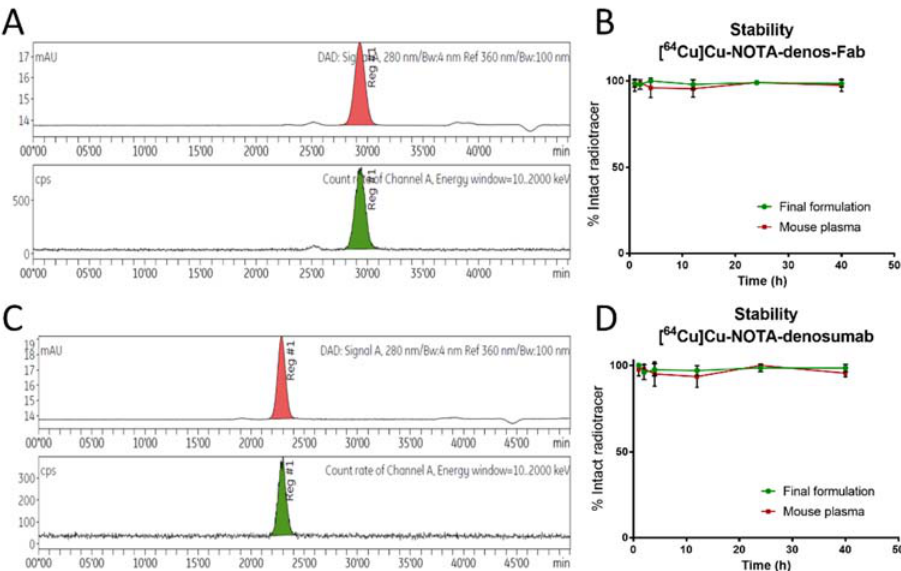
Cell binding of both radiotracers to a positive cell line (RANKL ‐ ME ‐ 180) and negative cell line (native ME ‐ 180) was evaluated in vitro to visualize target binding and specificity. The percentage associated cell ‐ bound activity for [ 64 Cu]Cu ‐ NOTA ‐ denos ‐ Fab was signifi ‐ cantly higher on the RANKL ‐ transduced cells (6.7 ± 0.8%) compared with the blocking con ‐ Figure 2. [ 64 Cu]Cu-NOTA-denos-Fab/denosumab characterization. ( A ) SEC-HPLC (Superdex 200 trol (0.5 ± 0.2%; p = 0.0003) and ME ‐ 180 cells (0.3 ± 0.03%; p = 0.0002, Figure 3A). Consecu ‐ Figure 2. [ 64 Cu]Cu ‐ NOTA ‐ denos ‐ Fab/denosumab characterization. ( A ) SEC ‐ HPLC (Superdex 200 increase 10/300) of [ 64 Cu]Cu-NOTA-denos-Fab; upper part UV signal, bottom part radioactive increase 10/300) of [ 64 Cu]Cu ‐ NOTA ‐ denos ‐ Fab; upper part UV signal, bottom part radioactive chan ‐ tively, at a radiotracer concentration of 20 nM, binding was also higher on RANKL ‐ trans ‐ nel. ( B ) Stability of [ 64 Cu]Cu ‐ NOTA ‐ denos ‐ Fab in mouse plasma and final formulation. ( C ) UV and channel. ( B ) Stability of [ 64 Cu]Cu-NOTA-denos-Fab in mouse plasma and final formulation. ( C ) UV duced cells (2.4 ± 0.2%) compared with blocking (0.3 ± 0.02%; p < 0.0001) and control ME ‐ radio ‐ SEC ‐ HPLC chromatograms of [ 64 Cu]Cu ‐ NOTA ‐ denosumab after radiosynthesis; upper part and radio-SEC-HPLC chromatograms of [ 64 Cu]Cu-NOTA-denosumab after radiosynthesis; upper 180 cells (0.3 ± 0.05%; p < 0.0001, Figure 3B). A reduced percentage (%) cell ‐ bound activity UV signal, bottom part radioactive channel. ( D ) Stability of [ 64 Cu]Cu ‐ NOTA ‐ denosumab in mouse part UV signal, bottom part radioactive channel. ( D ) Stability of [ 64 Cu]Cu-NOTA-denosumab in was seen with higher radiotracer concentrations due to the cold mass effect, as described plasma and final formulation (data graph: mean ± 1 standard deviation). mouse plasma and final formulation (data graph: mean ± 1 standard deviation). before [30].